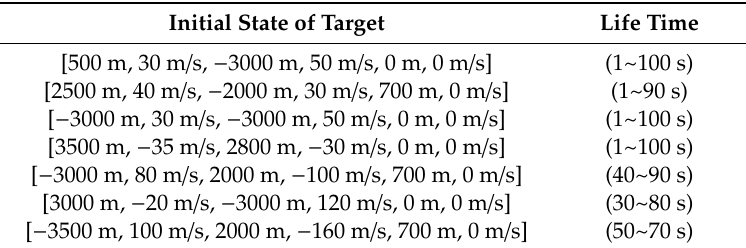
Table 1. The true movement of targets.